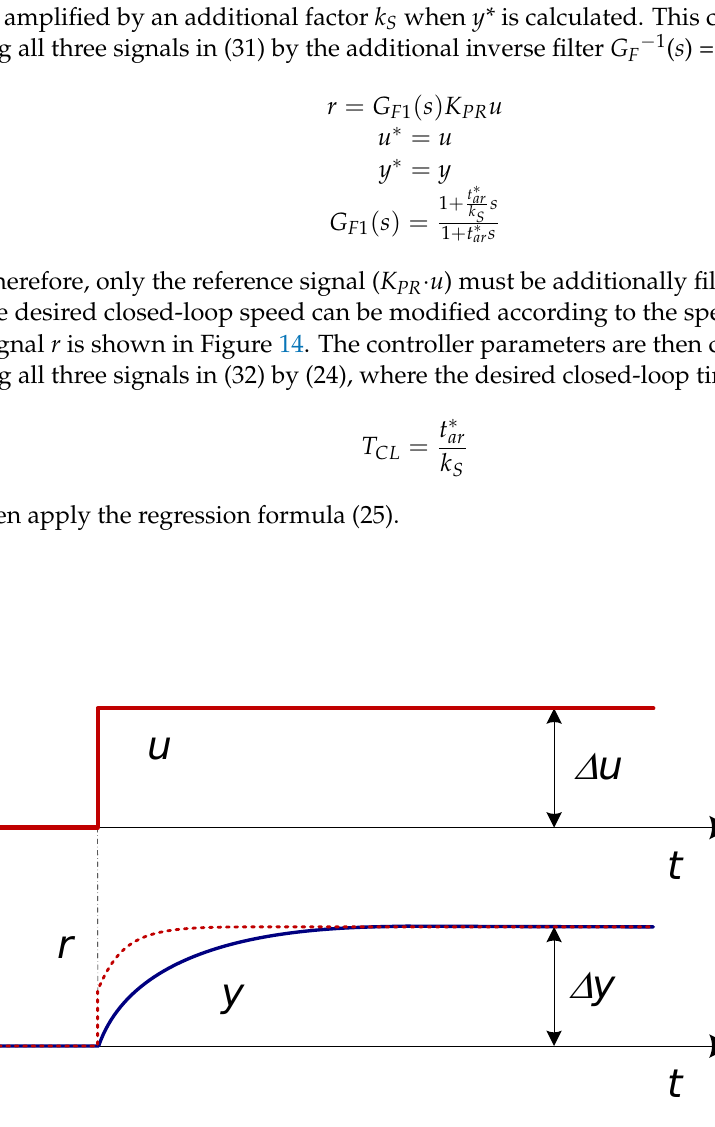
Figure 14. Measured process input ( u ) and output ( y ) signals with artificially calculated reference ( r ) signal (dashed line) represented by r = G F 1 ( s ) K PR ∙ u .